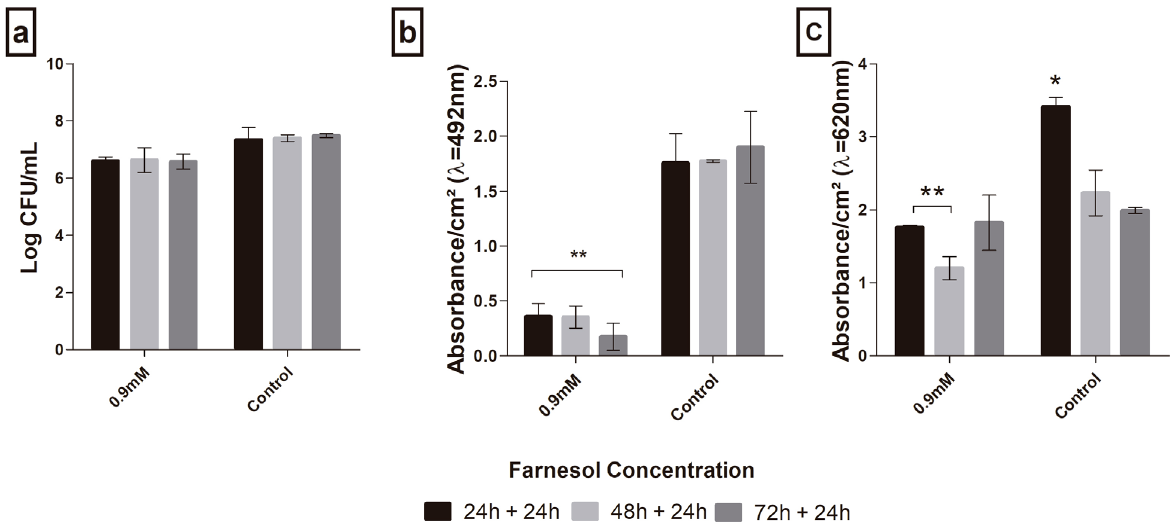
Figure 4. Evaluation of farnesol on biofilm preformed by Rhodotorula mucilaginosa ATCC 64684: (a) Colony forming unit (CFU); (b) Metabolic activity (XTT); (c) Total biomass production (CV). *Statistical difference between controls. **Statistical difference between controls and treated. Control: a similar experiment without farnesol. All tests were performed in triplicate and on three independent days. Data with a non-normal distribution were expressed as the mean ± standard deviation